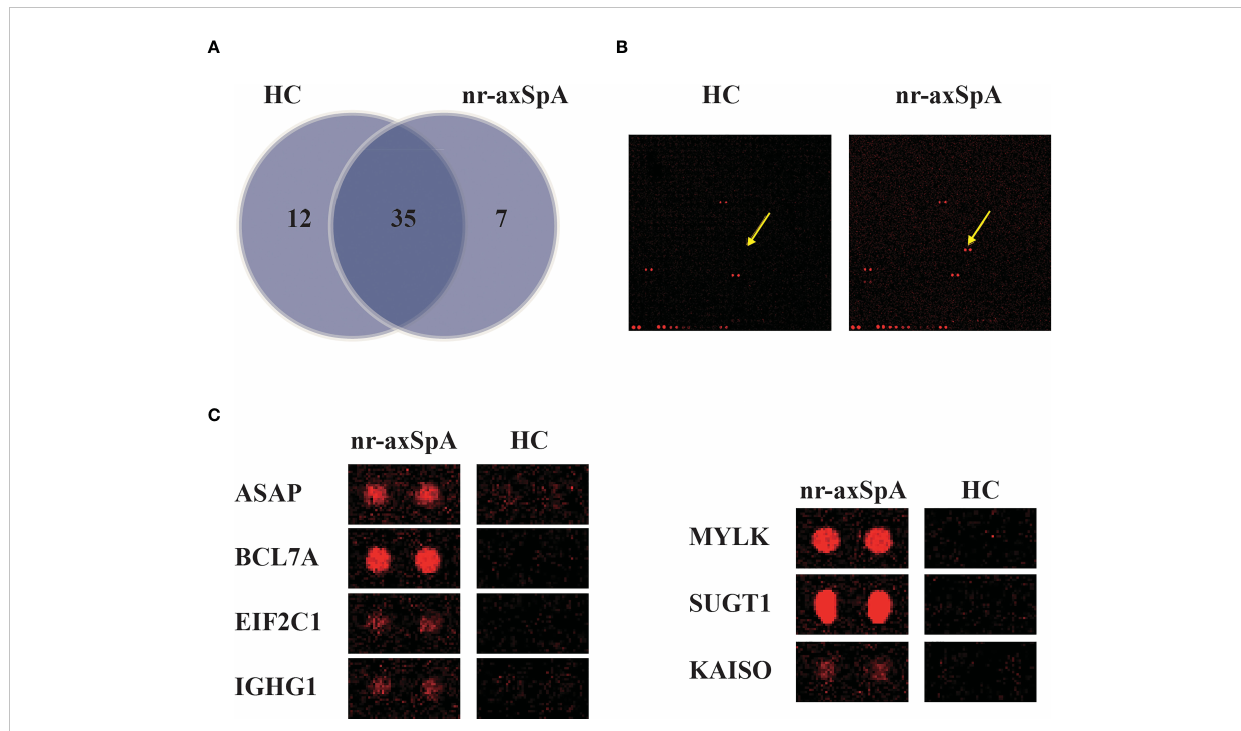
FIGURE 1 Identi fi cation of autoantibodies in the serum of patients with nr-axSpA using human proteome (HuProt) microarrays. (A) The Venn diagram shows the number of autoantibodies identi fi ed in the serum of patients with nr-axSpA and healthy controls. (B) Representative images of the autoantibody detected in the HuProt microarrays. The arrows indicate the duplicate spots of the antigen protein. (C) High magni fi cation images of the seven speci fi c autoantibodies, including ASAP, BCL7A, EIF2C1, IGHG1, MYLK, SUGT1, and KAISO, identi fi ed in patients with